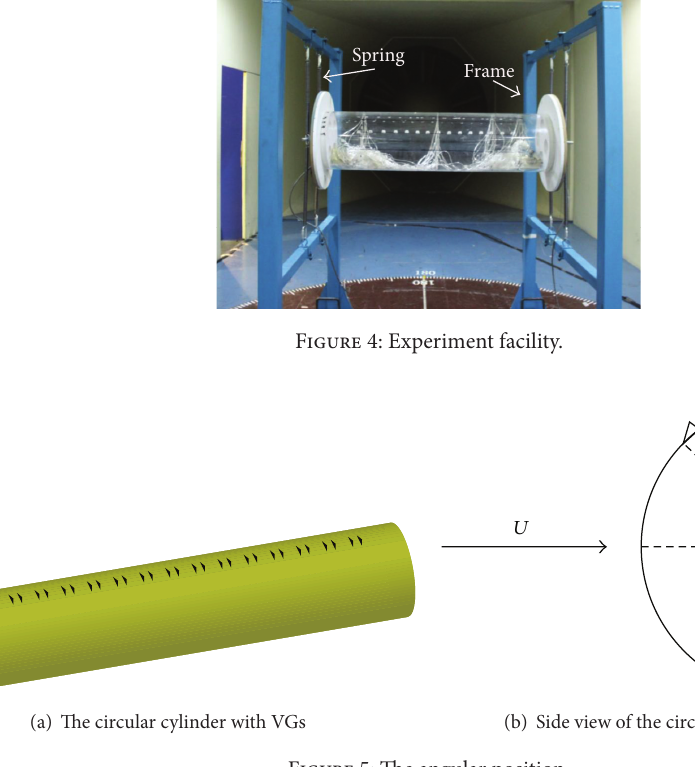
Figure 5: The angular